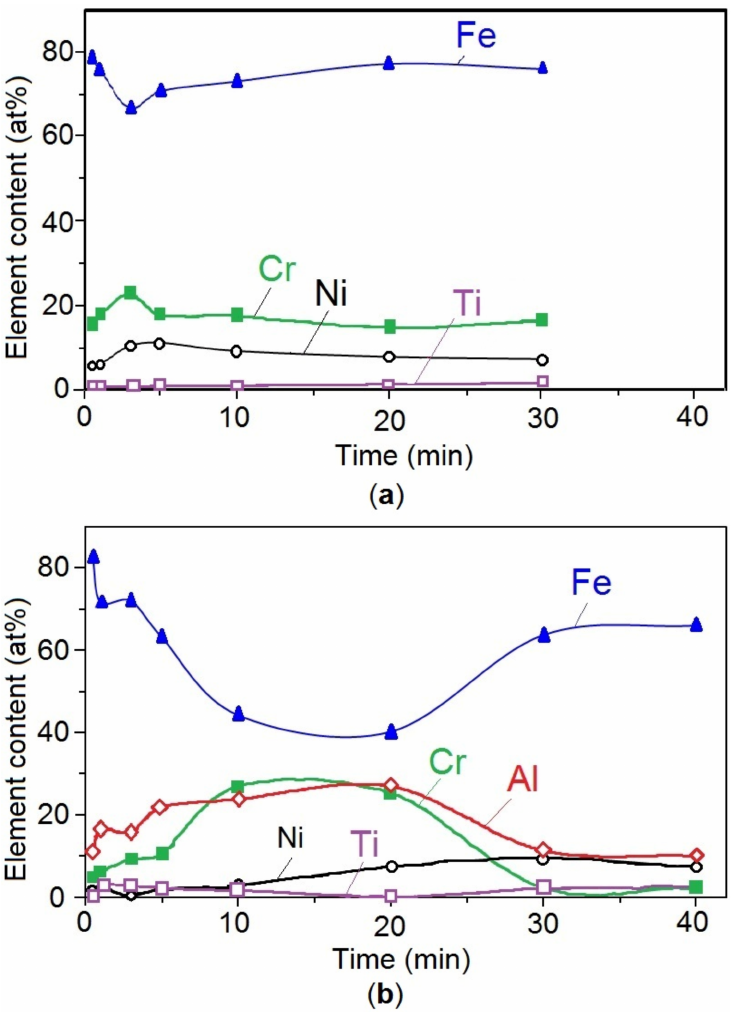
Figure 3. Depth distributions (XPS data) of the elemental composition of sample surface before ( a ) and after ( b ) Al-ion implantation obtained using layer-by-layer etching of surface with argon ions with an energy of ~4 keV at an etching rate of ~1 nm/min, i.e., here 1 min of tentative corresponds to 1 nm of